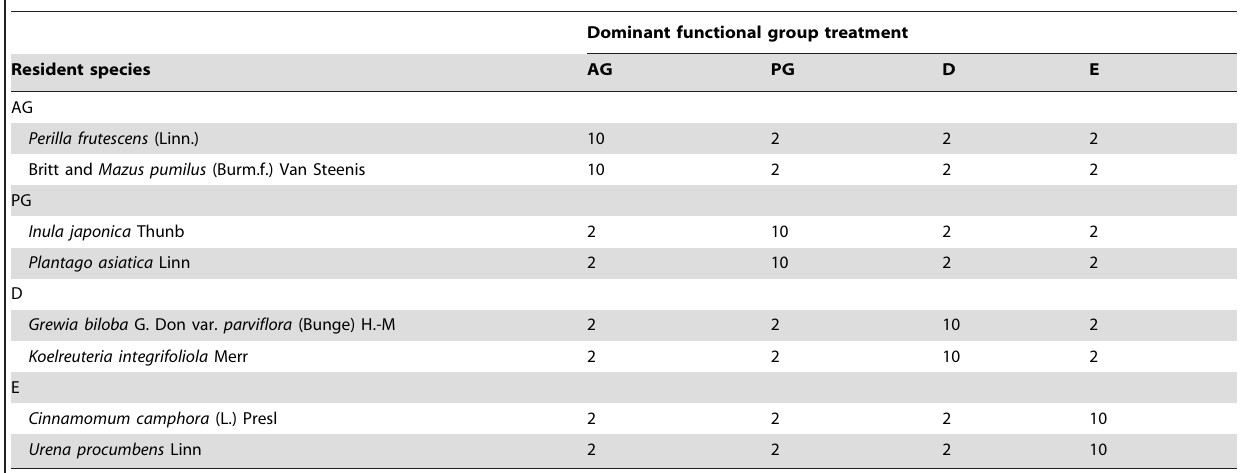
Table 1. The number of transplanted seedlings in different dominant functional group treatments.